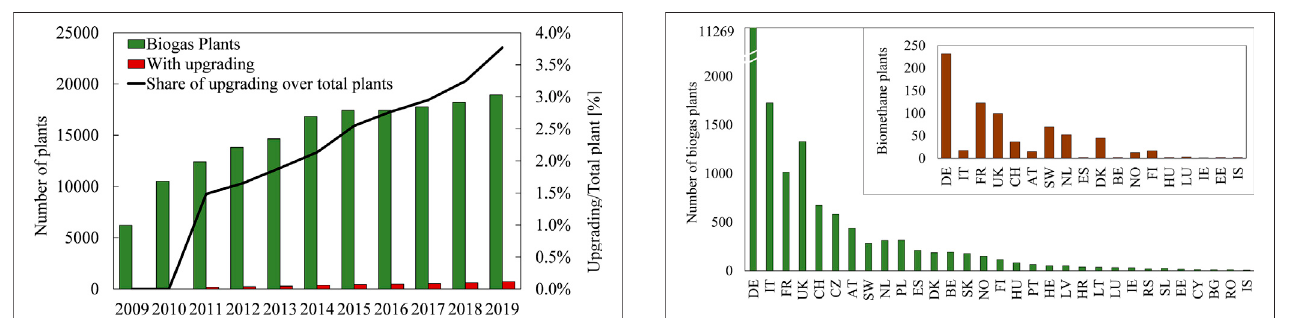
FIGURE3| Biogas andbiomethane plantsinstalled inEuropeattheend of 2019. Adapted from (European Biogas Association, 2020; International Energy Agency,